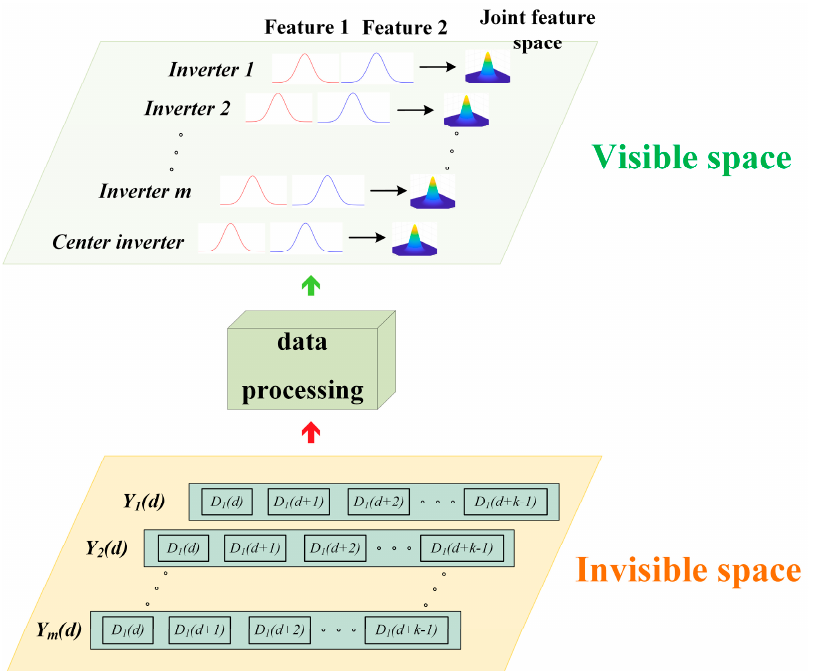
Figure 3. Formulation and utilization of the monitoring data.